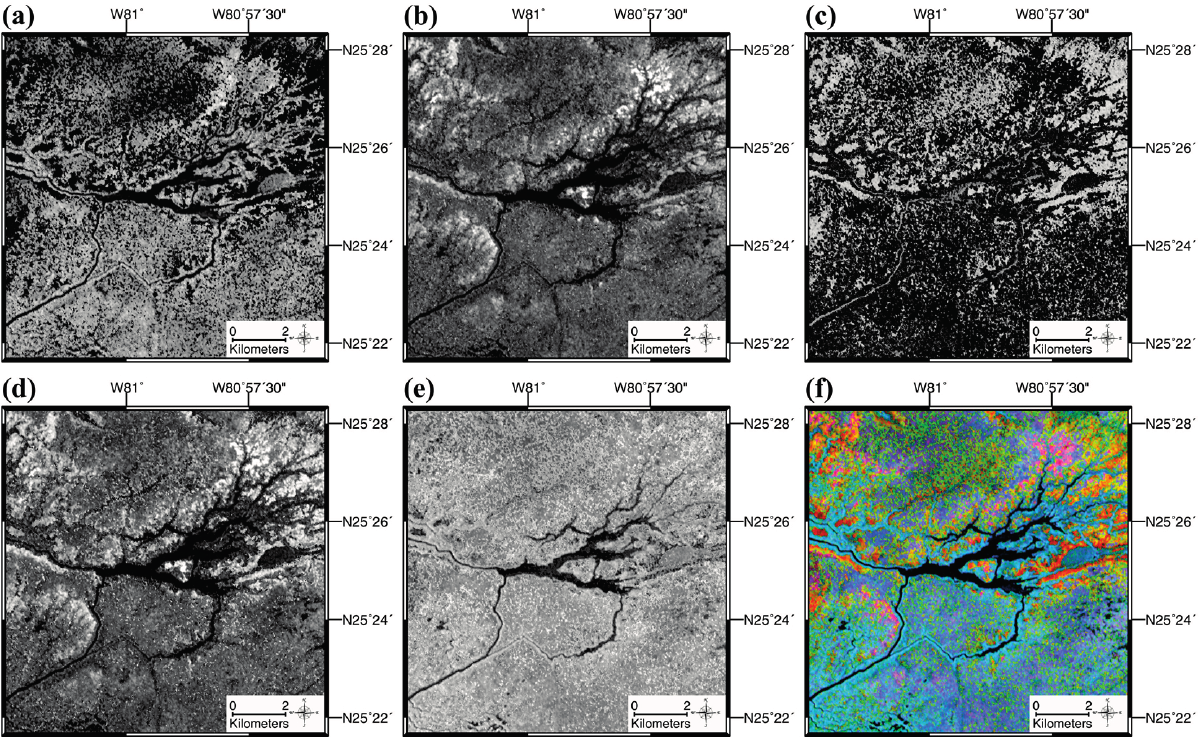
Figure 3. Hong & Wdowinski decomposition analysis of TerraSAR-X (TSX) quadruple polarimetric data acquired over the study area. ( a ) Single bounce component; ( b ) Double bounce component from co-pol; ( c ) Double bounce component from cross-pol; ( d ) Double bounce component from both the co- and cross-pol; ( e ) Volume scattering component; ( f ) Color composite image using our decomposition: blue = single bounce, red = double bounce (both from the co- and the cross-pol), and green = volume